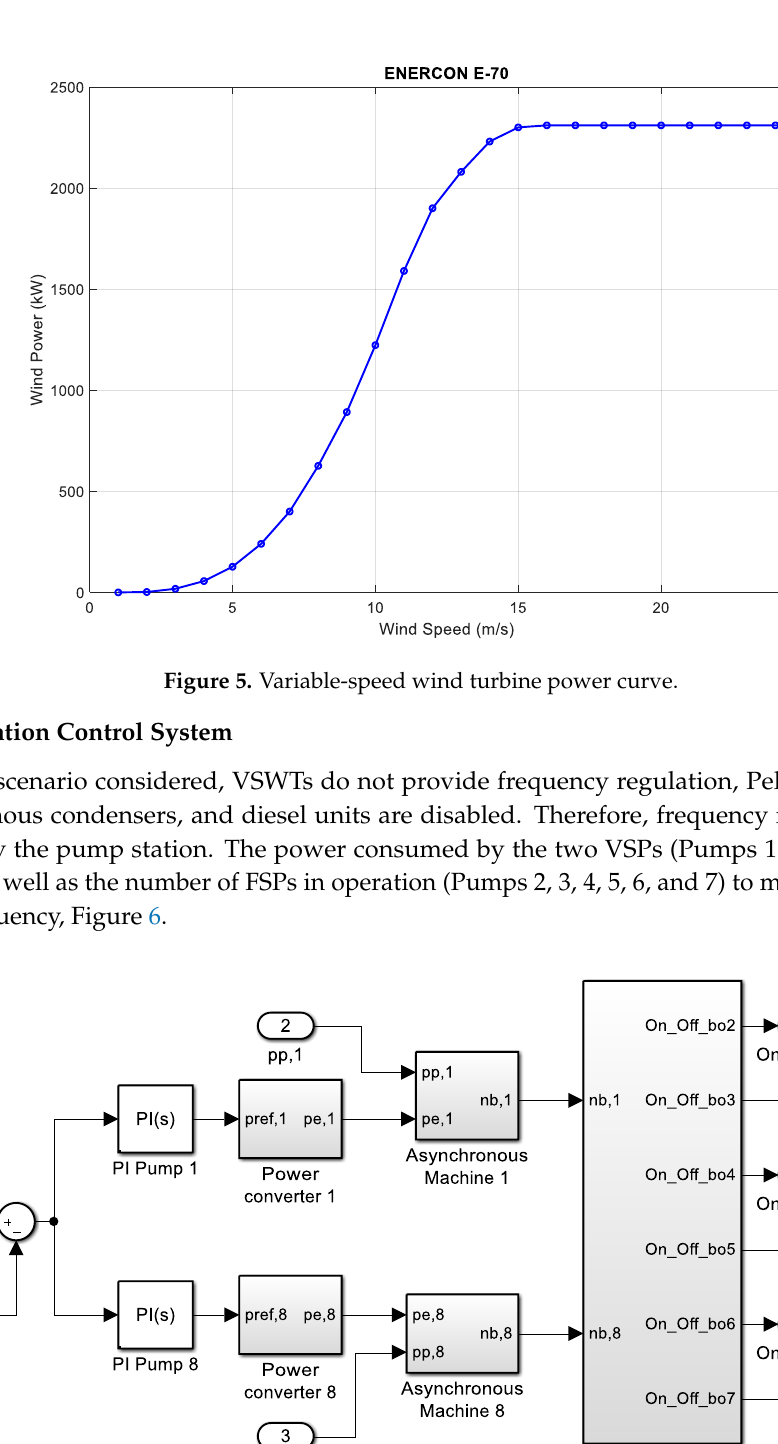
Figure 5. Variable-speed wind turbine power curve.